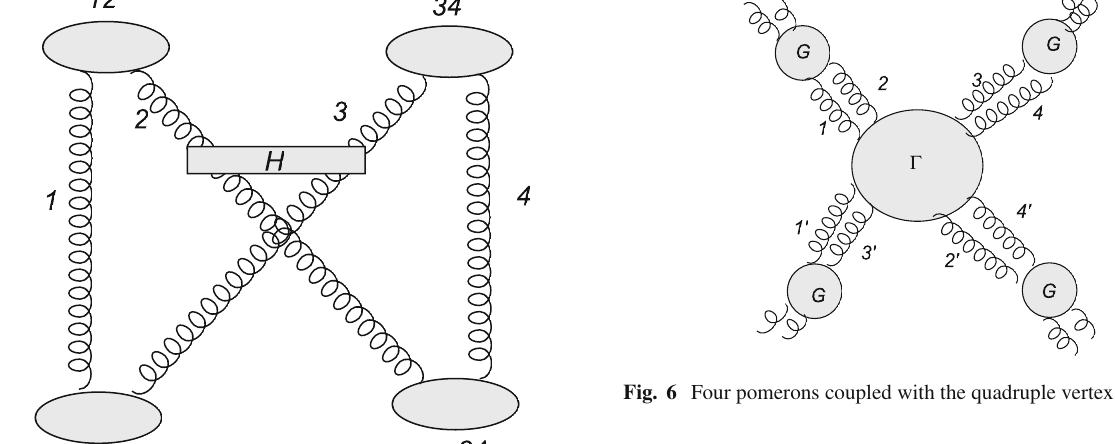
4 The quadruple pomeron vertex and